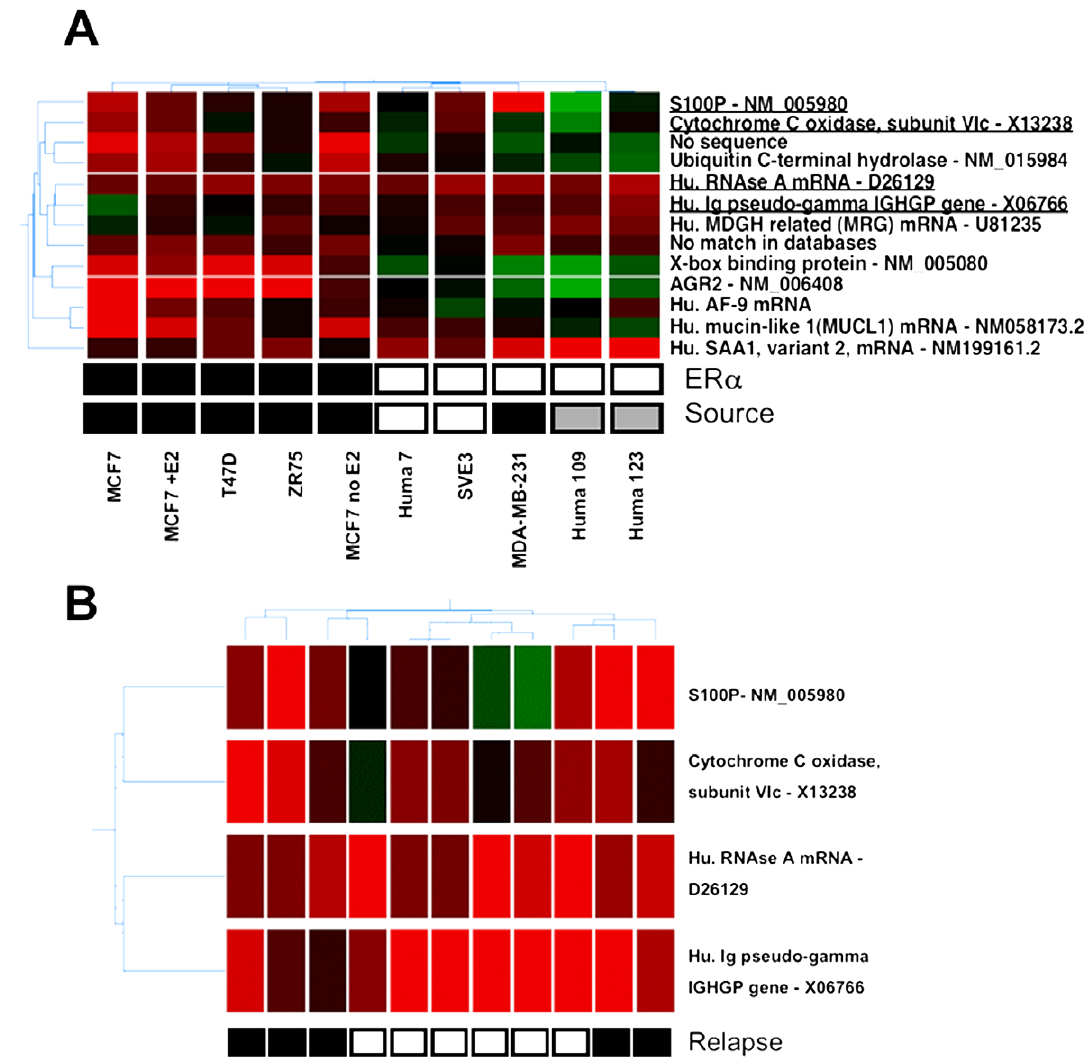
Fig. 2. Cell-line and tumour data clustered on tumour-selected genes as a two fold expression difference. Dendograms represent hierarchical clustering of genes (left) and samples (top) using Pearson correlation as a similarity measure. (A) Genes identified from tumour samples by expression filtering are meaningful for cell-lines; four relapse-associated genes are underlined, the remaining 9 genes were positively associated with immunohistochemical ER α protein positivity. ER α : black boxes are cell lines which are ER α protein-positive; white boxes are cell lines which are ER α protein-negative. Source: black boxes are cell-lines from malignant tumours; grey boxes are cell-lines from benign tumours; white boxes are cell-lines derived from normal tissue. Hu. – Human; MDGH – Mammary-derived growth inhibitor; SAA1 – Serum amyloid A1. (B) Tumour data clustered on 4 genes selected as 2-fold expression difference between relapsed and non-relapsed cases. Relapse: black boxes are tumours from cases with earlier relapse (mean time to relapse was 15 months); white boxes are tumours from cases without relapse at follow-up (mean relapse-free follow-up was 67 months). Colouring according to relative expression: red – higher, green – lower, black –